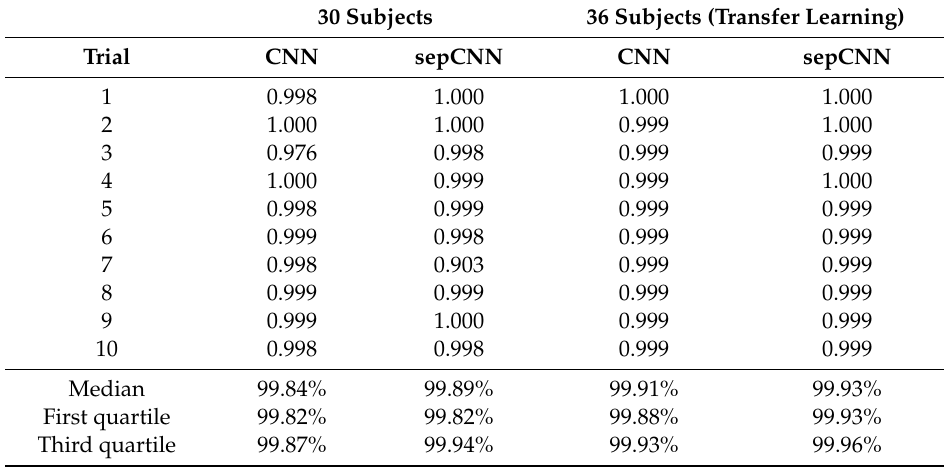
Table 2. Classification performance. Correct classification rate (accuracy) of the best